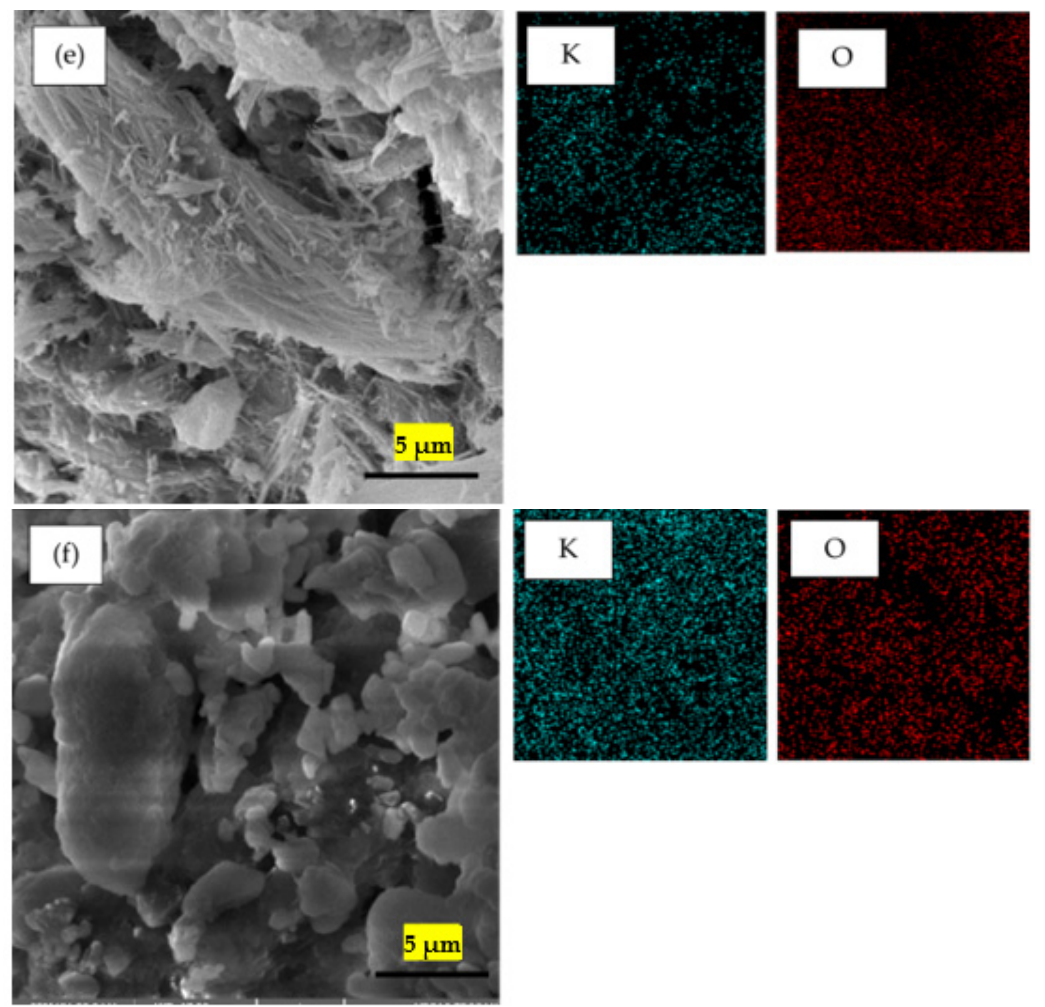
Figure 4. SEM images and EDX mapping for ( a ) powder Al 2 O 3 , ( b ) beads Al 2 O 3 , ( c ) powder KOH/Al 2 O 3 , ( d ) beads KOH/Al 2 O 3 , ( e ) powder K 2 CO 3 /Al 2 O 3 , and ( f ) beads K 2 CO 3 /Al 2 O 3 .